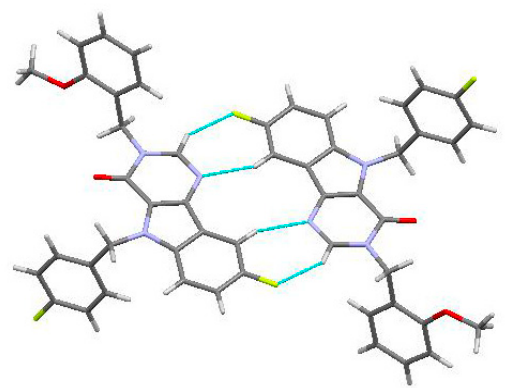
Figure 4. Columns of the dimers in the crystal phase. 2.3. Hirshfeld Surface Analysis The peculiarities of the crystal packing were caused by the capability of the molecule to form certain types of intermolecular interactions. On the other hand, the biological activity depends on the formation of intermolecular interactions between the target molecule and the corresponding receptor. Thus the study of intermolecular interactions is a very important task. One of the newest methods for intermolecular interactions analysis in the crystal phase is the study of Hirshfeld surfaces and 2D fingerprint plots generated using the CrystalExplorer program [25]. The Hirshfeld surfaces and their associated 2D fingerprint plots for the title Compound ( 3 ) were calculated taking the data of the single-crystal X-ray crystal structure as input. The Hirshfeld surface emerged from an attempt to define the space occupied by a molecule in a crystal for the purpose of partitioning the crystal electron density into molecular fragments [26]. It provided a 3D picture of the close contacts in the crystal, and these contacts can be summarized in a fingerprint plot [27]. The areas of the short contacts are shown by a red color on the Hirshfeld surfaces, while the long distances can be detected as the blue areas (Figure 5). The intermolecular interactions outward the H···H/C···H/F···H/O···H/N···H/C···C/C···N/C···F/C···O/N···F contacts, as well as the overall fingerprint region of the title molecule, are displayed in Figure 5. With this analysis, the division of contributions is possible for different interactions including H···H, N···H, C···H, and O···H, which commonly overlap in the full fingerprint plots. Figure 6 shows the d norm surface of Compound ( 3 ), the contribution from the C…H/H…C contacts, corresponding to the C—H… π interaction, is